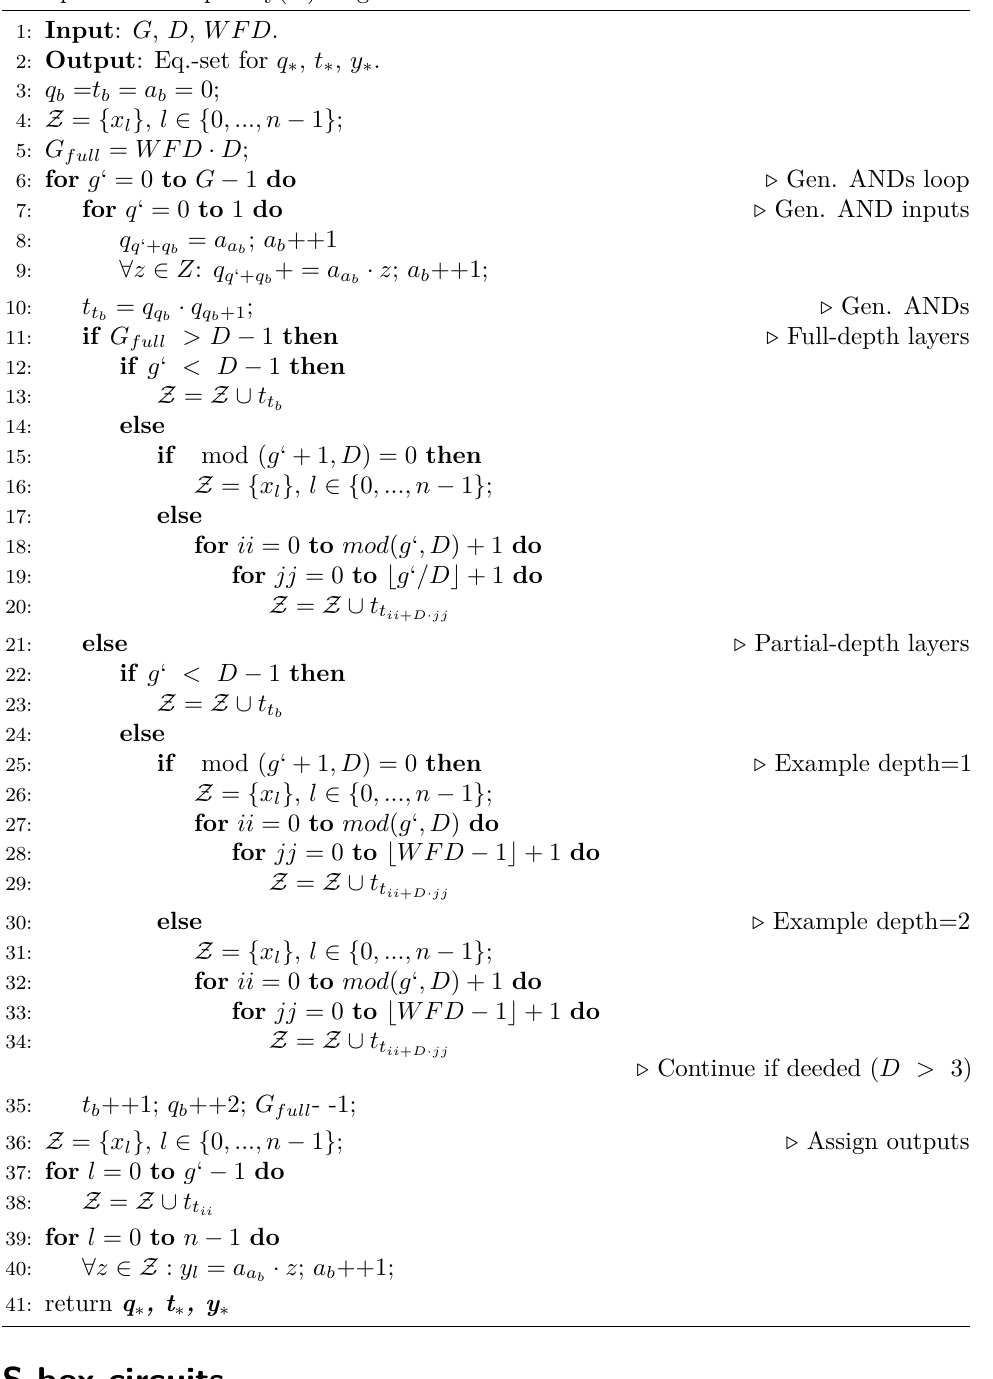
Algorithm 1 Generate ANF equations for joint multiplicative-depth ( D ) and multiplicative-complexity( G )